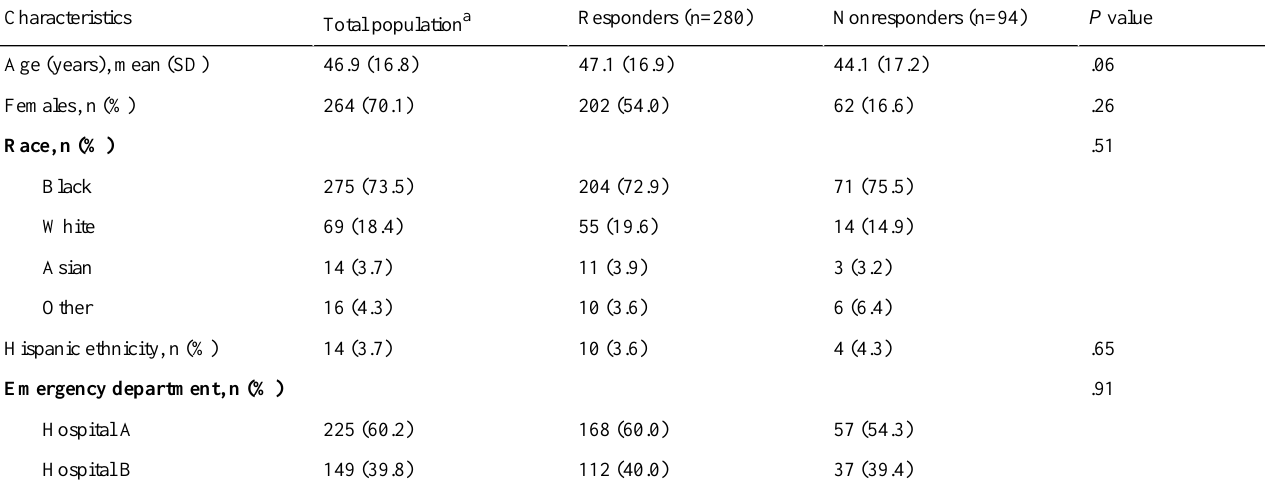
Table 1. Participant demographics (N=374).